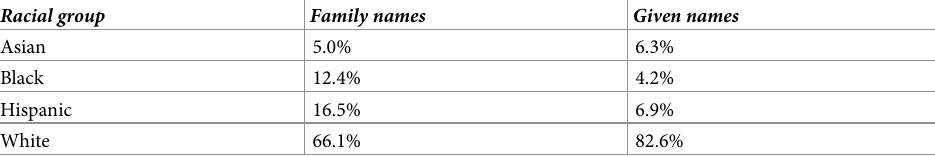
Table 2. Racial representation of family names (U.S. Census) and given names (mortgage